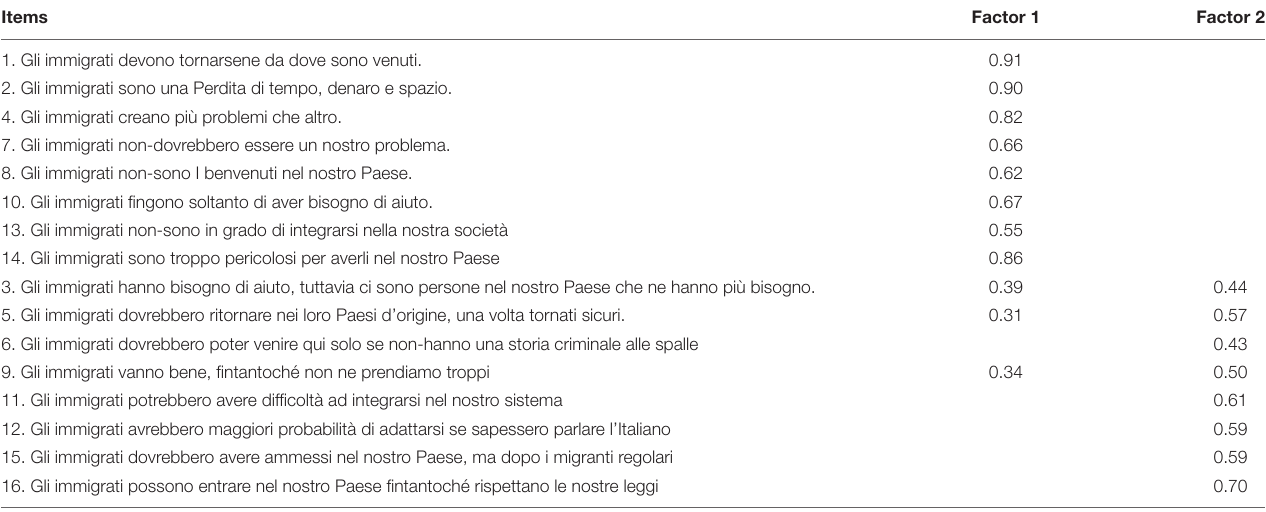
TABLE 2 | Factor loadings of the items of the three factors resulting from EFA ( N = 147).